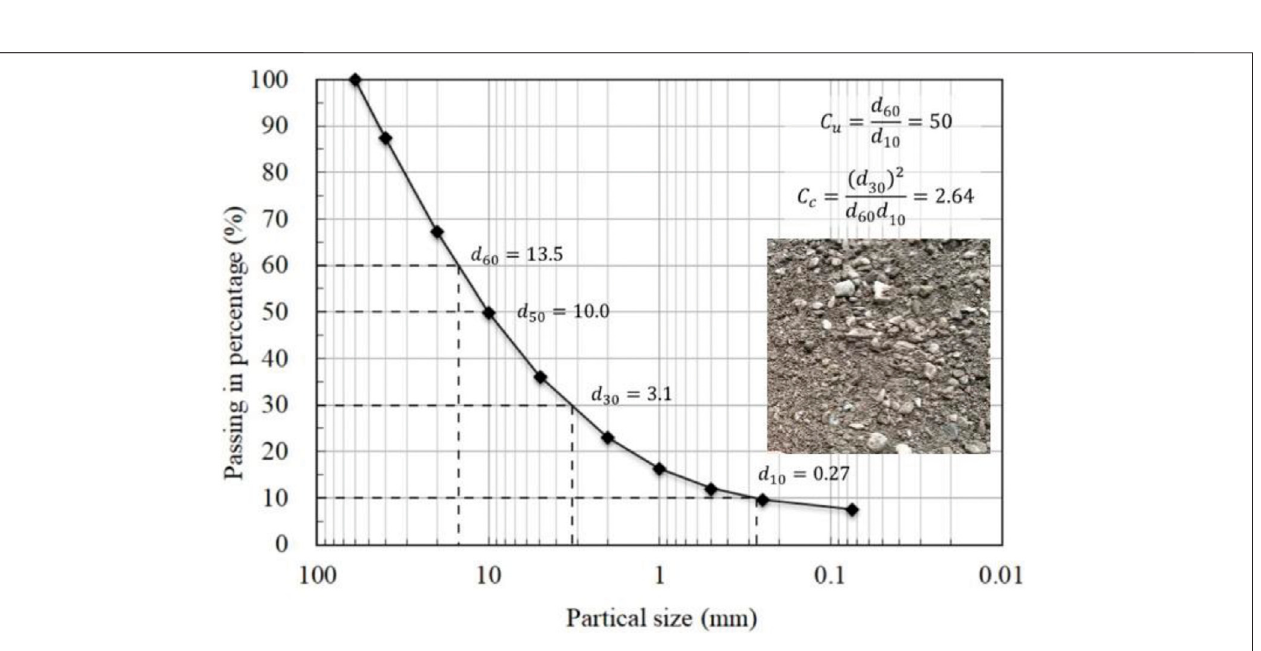
Frontiers in Earth Science |